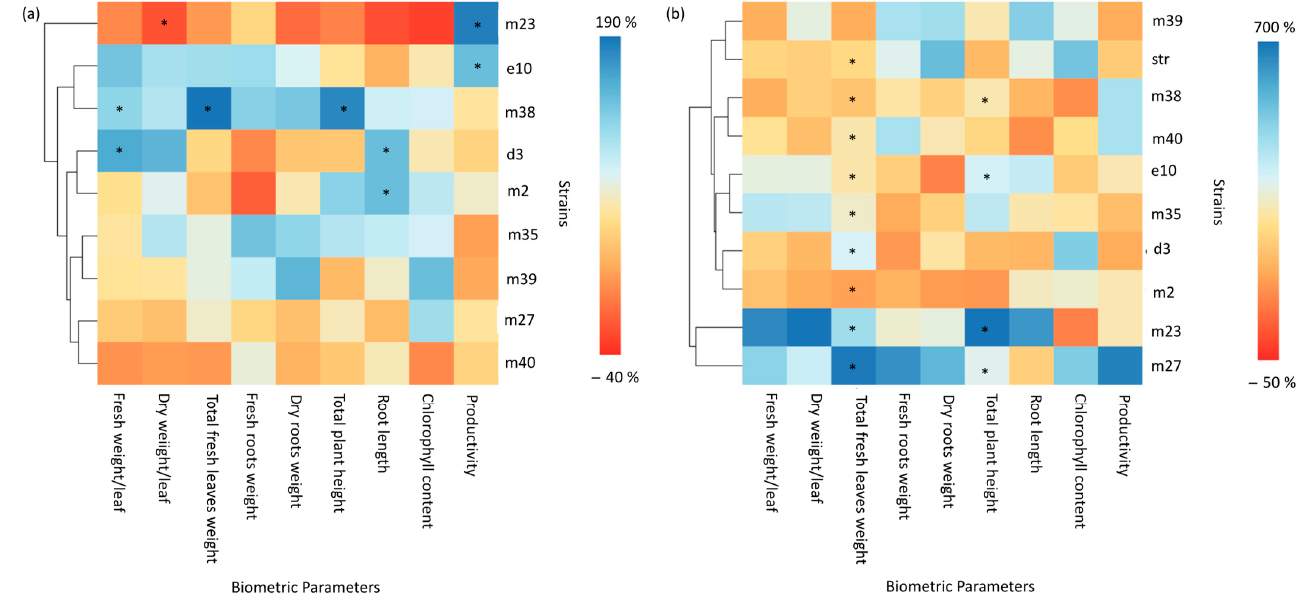
Figure 3. Biometric parameters of leaves of inoculated plants under no stress ( a ) or after X. fragariae inoculation ( b ), expressed as percentage increase/decrease with respect to unstressed or X. fragariae + water-inoculated plants. Color scale ranges from red (lower values than the control) to blue (higher values than the control). Asterisks indicate parameters significantly different from the control, according to Student’s t-test at p -value < 0.05 ( n = 5).